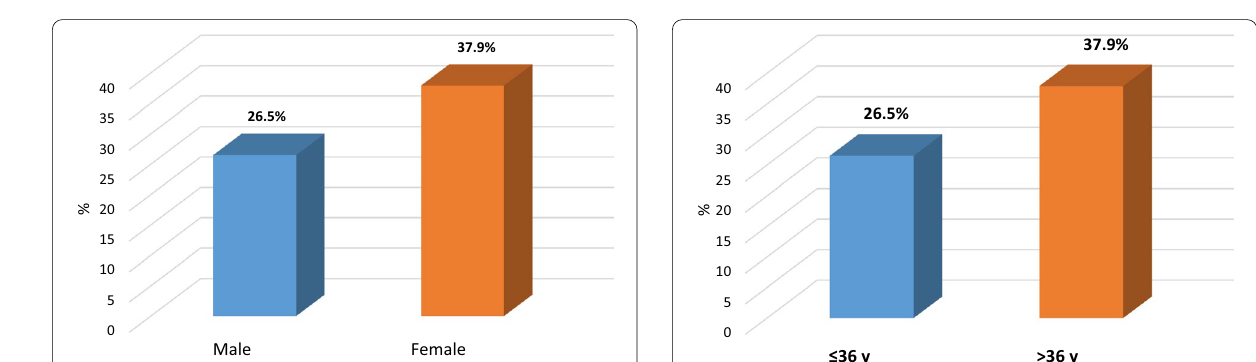
Fig. 4 Age of the patients as predictor of moderate and severe